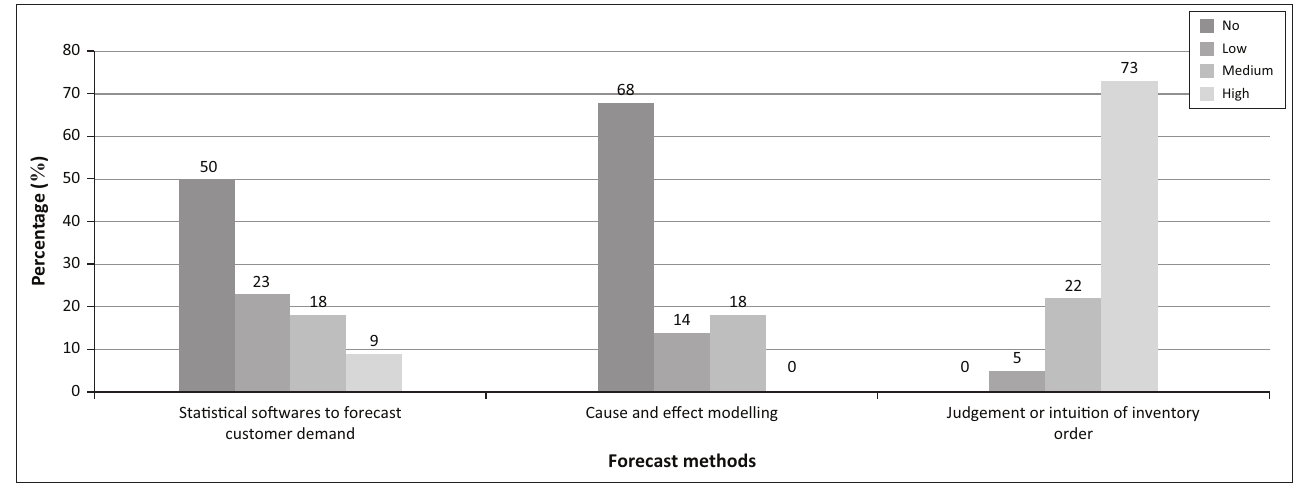
FIGURE 1: Forecast methods used (respondents’ rating in %